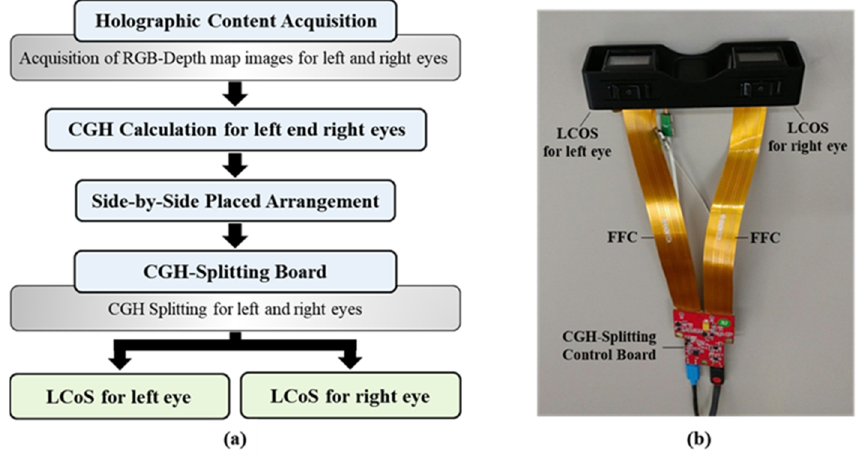
Figure 1. ( a ) Block diagram that shows the image data processing for dual-view holographic content (CGH). ( b ) Mockup prepared to show the module of dual-view near-eye holographic 3D display (NEHD).